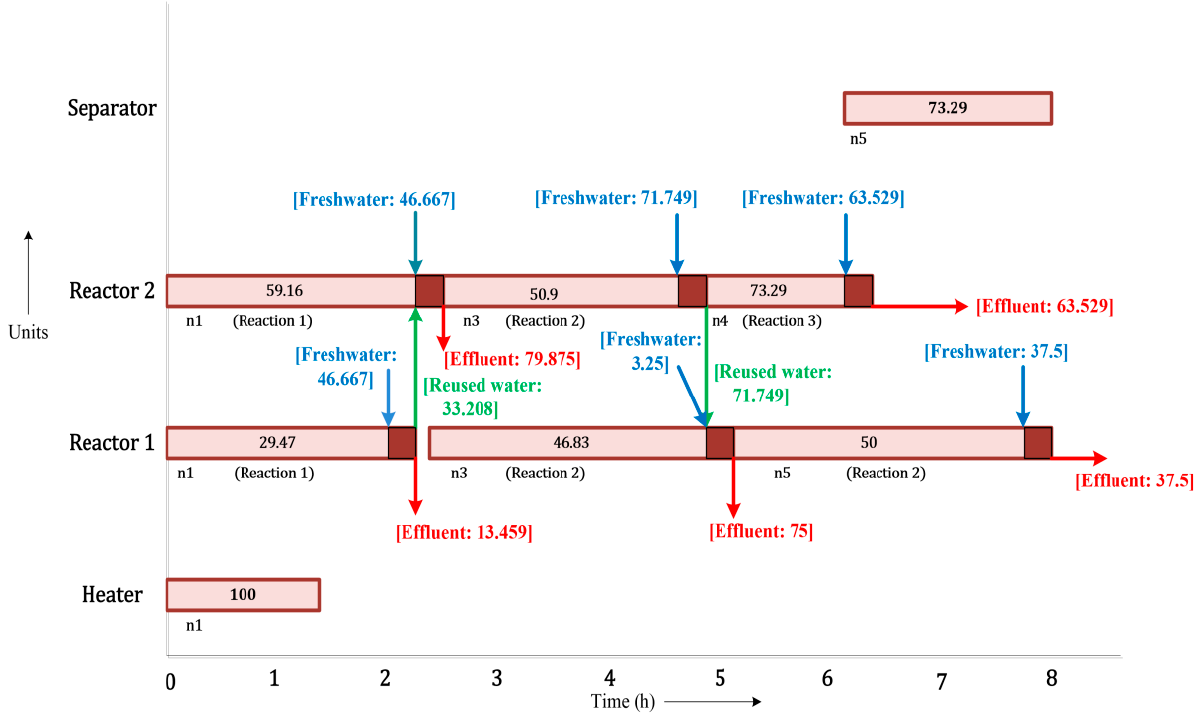
Figure 8. Gantt chart for the simultaneous approach without a water storage tank for case study 1.